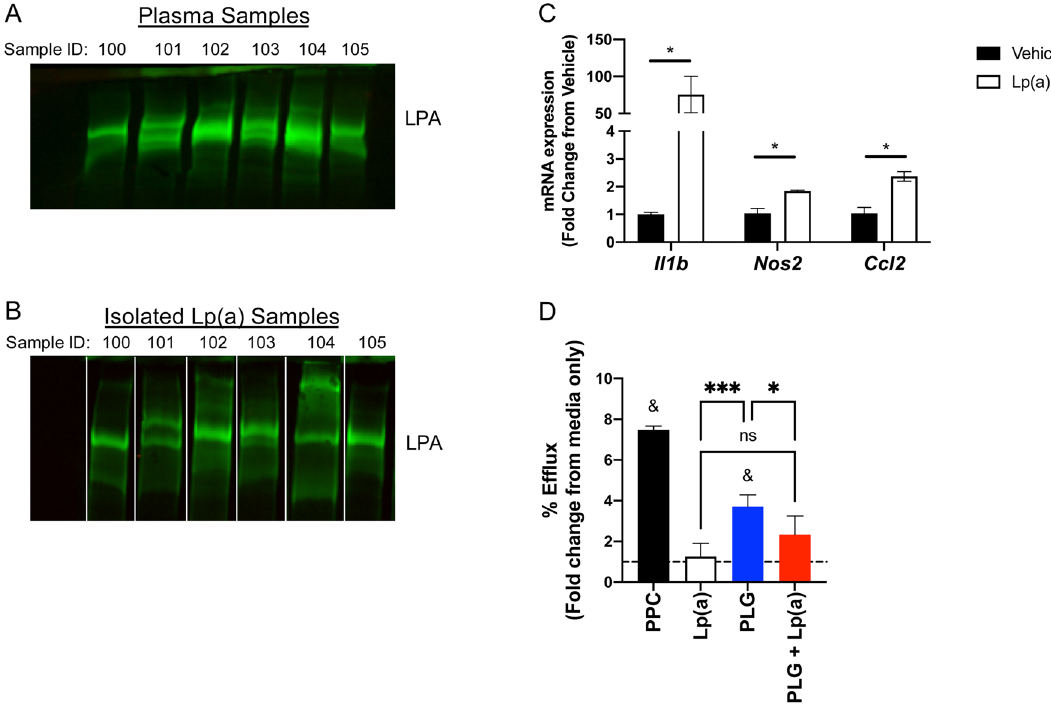
Figure 4. Small-volume isolation yields biologically active Lp(a) suitable for translational research. ( A ) Western blot using whole plasma from subjects with elevated Lp(a). LPA (green) is visualized above 460kD. The uncropped gel is presented in Supplemental Fig. 5. ( B) Western blot was performed using Lp(a) isolated with our small-volume technique and LPA (green) visualized above 460kD. The original gel was cropped and lanes rearranged to match whole plasma presented in A. The unedited and uncropped gel is presented in Supplemental Fig. 6. ( C ) C57BL6/J mice were injected intraperitoneally with 3 mL thioglycolate broth (3%) and macrophages were collected from the peritoneum 4 days later. Macrophages were allowed to adhere to 6-well plates overnight and then treated for 24 h with DMEM containing 2% serum from Ldlr -/- mice fed high-fat diet for 12 weeks to generate foam cells. Macrophage foam cells were treated with vehicle (black bars) or Lp(a) (15µg/ mL; white bars) for 4 h. Il1b , Nos2 , and Ccl2 gene expression was determined via qRT-PCR as described in Materials and Methods. Lp(a) was derived from our small-volume isolation method and performed using Lp(a) from 4 separate subjects. Unpaired students t-test was used to identify differences between vehicle and Lp(a) treatment. * P < 0.05. (D) HEK293T cells were transfected with wildtype ABCA1 and radiolabeled with [ 3 H] cholesterol overnight. Radiolabeled cells were treated for 4 h with pooled plasma control (black bar), isolated Lp(a) (15µg/mL; white bar) from 4 separate subjects, plasminogen (5µg/mL; blue bar), and pre-treatment of Lp(a) (15µg/mL) for 10-min followed by plasminogen (5µg/mL; red bar). Cholesterol efflux to the cholesterol acceptors was calculated as described in Materials and Methods and percent efflux (% efflux) is presented as fold change over radiolabeled cells treated with media only. One-way ANOVA with Tukey’s multiple comparisons test was used to identify differences among treatment groups. * P < 0.05; *** P < 0.001. One sample t and Wilcoxon test was used to determine differences between treatment and media only control. & P < 0.05. Figures 4C and